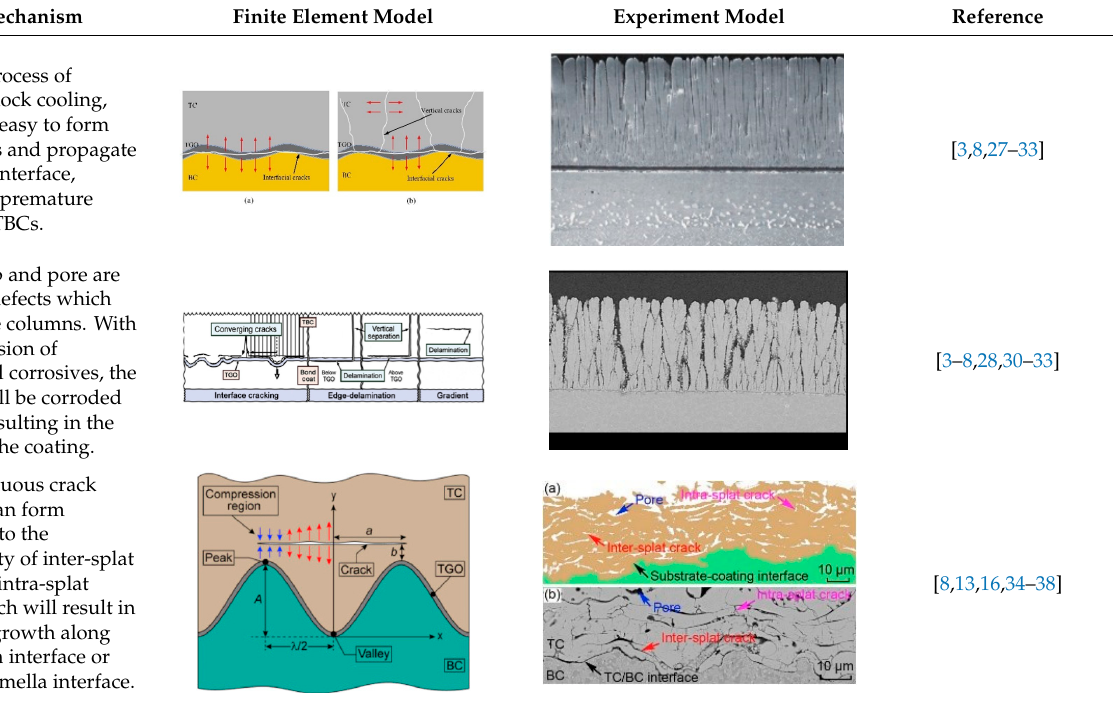
Table 1. Comparison of EV-PVD, PS-PVD, APS.